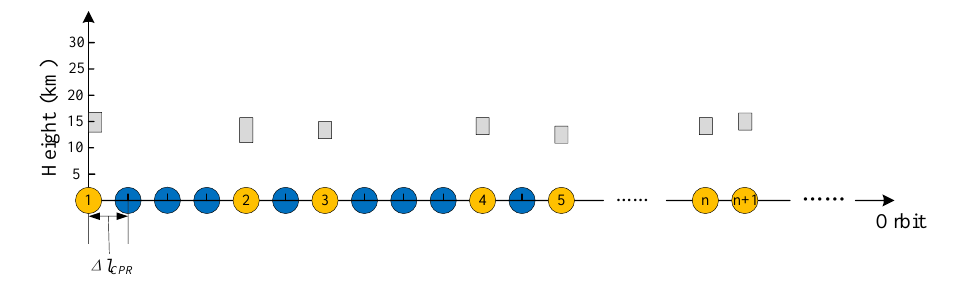
Figure 4 . Hypothetical distribution of CloudSat pixels of an arbitrary cloud